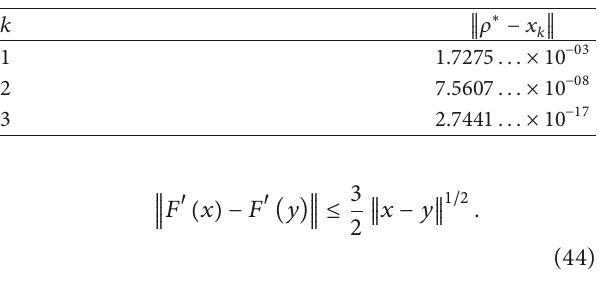
Table 2: Absolute error obtained by